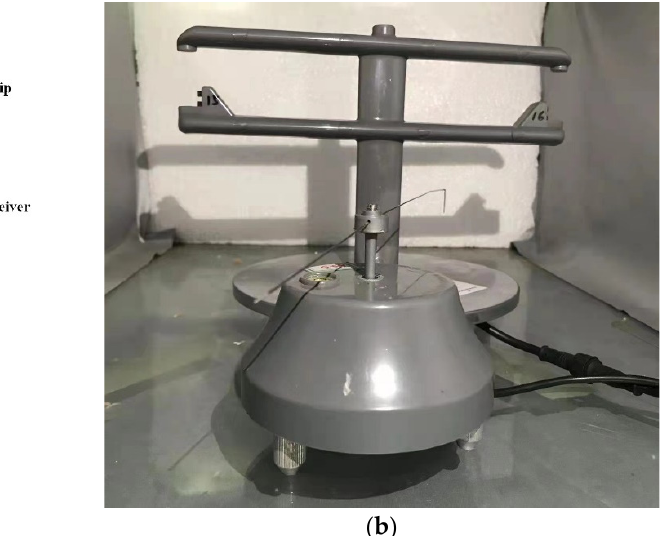
Figure 4. Flight mill (for checking the flight ability of spongy moths): ( a ) Details of flight mill; ( b ) Flight mill used during the experiment.